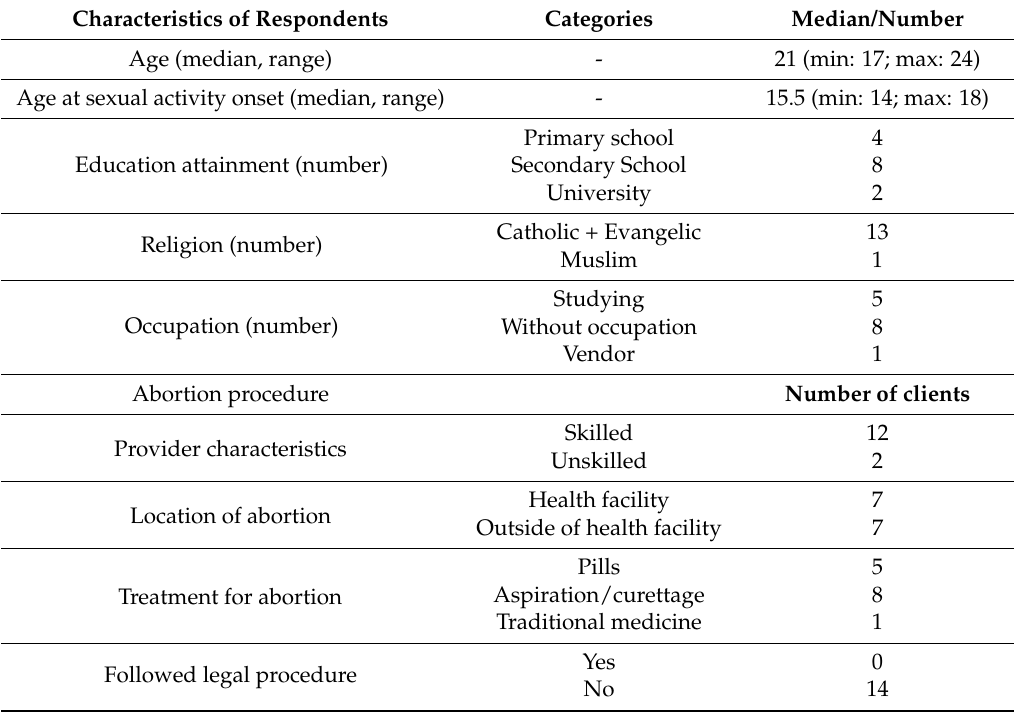
Table 1. Socio-demographic characteristics and abortion